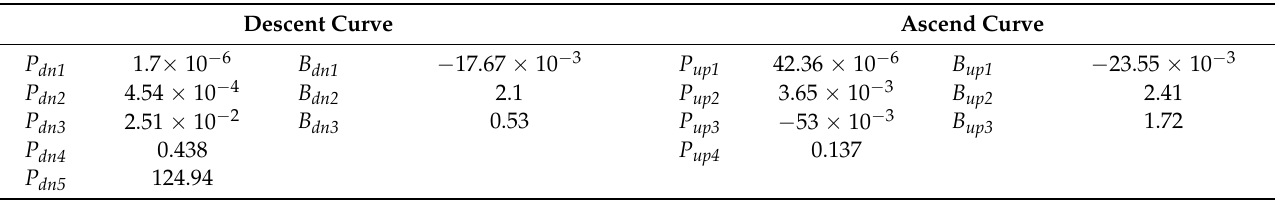
Table 3. Hysteresis equation parameters.